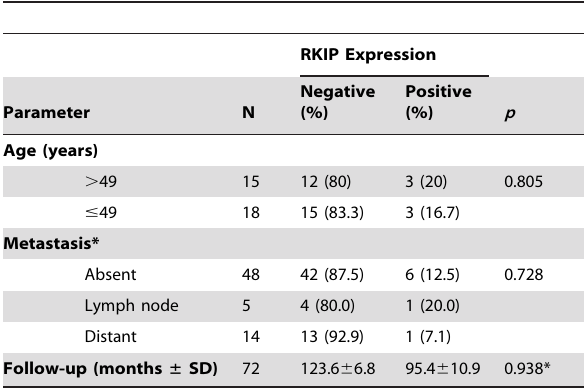
Table 2. Correlations between RKIP expression and cervical cancer patient’s clinical